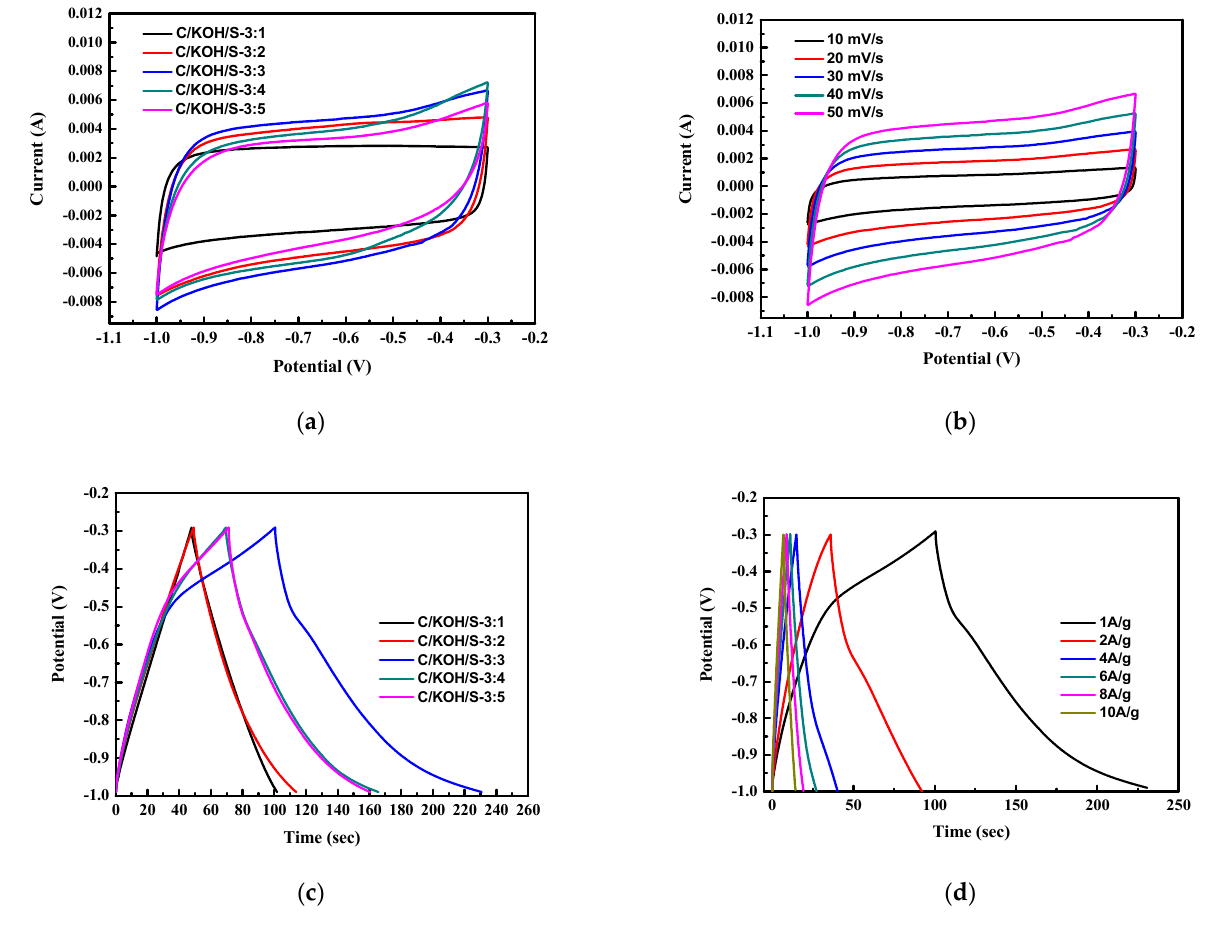
Figure 7. CV curve at 50 mV s − 1 of the heteroatom-co-doped AC electrode prepared by adding different weight ratios of ammonium persulfate ( a ), CV curve at a scan rate of 10–50 mV s − 1 of C/KOH/S-3:3 electrode ( b ), charge–discharge analysis of C/KOH/S electrodes with different weight ratios of ammonium persulfate ( c ) and GCD measurement of C/KOH/S-3:3 electrode at different current densities ( d ).